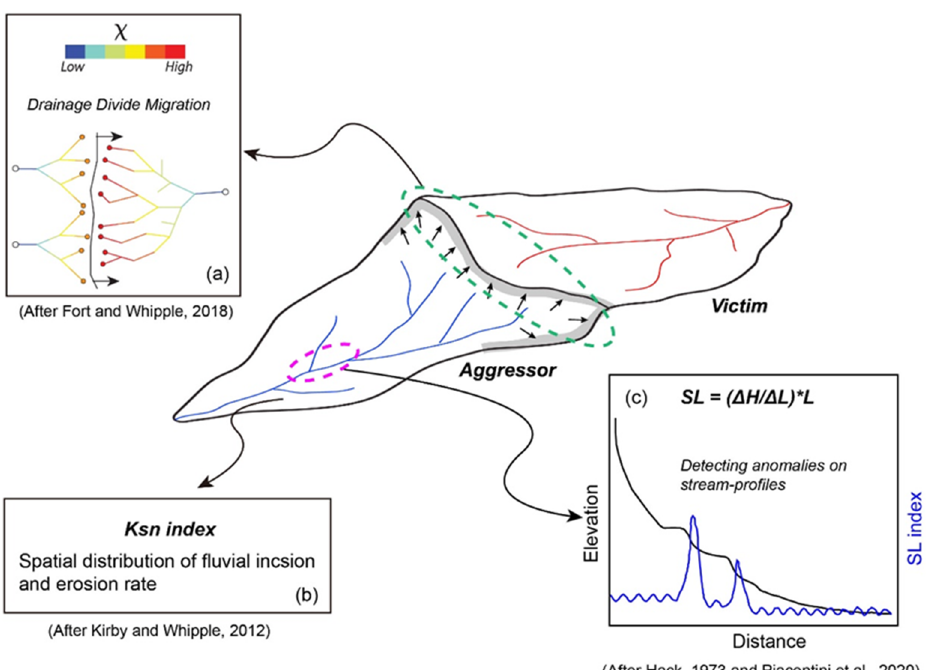
Figure 4. Cartoon plot show the methods adopted in this study on basis of basin scale (after [25]). ( a ) The parameter X provides a prediction of divide motion; ( b ) The Ksn index derived from Equation (1) indicate fluvial incision and associated with erosion rates; ( c ) The SL index (Equation (2)) highlights anomalous changes in river gradients.